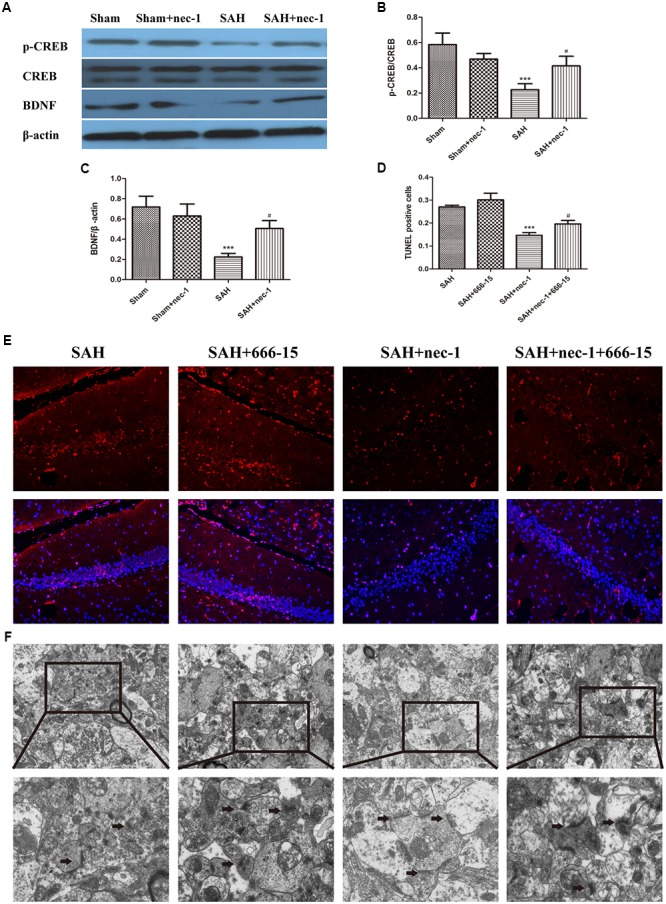
Pathways that nec-1 relies on to exert neuroprotective effects. (A–C) Western blotting was used to detect CREB, p-CREB, and BDNF. After SAH occurred, these three proteins showed an obvious decrease. However, the injection of Nec-1 increased expression of these three proteins. Bar graphs showing the quantification of the protein levels of p-CREB, CREB, and BDNF. The results are expressed as the p-CREB/CREB ratio and BDNF/β-actin ratio (n = 3). The values represent the mean ± SD., ∗∗∗P < 0.001, SAH vs. Sham, #P < 0.05 SAH+nec-1 vs. SAH. (D,E) TUNEL showed the apoptotic cells. In the SAH+nec-1 group, there are few TUNEL-positive cells, whereas there are many in the SAH+nec-1+666-15 group. Scale bar = 20 μm. (F) Transmission electron microscopy showed the structure of synapses. In the SAH and SAH+nec-1 groups, presynaptic structures were damaged and nec-1 treatment could alleviate synaptic impairment. In the SAH+nec-1+666-15 group, the protective effect of nec-1 was reversed. The arrows showed the structure of the presynaptic and postsynaptic membranes, and the synaptic cleft. Scale bar = 500 nm.